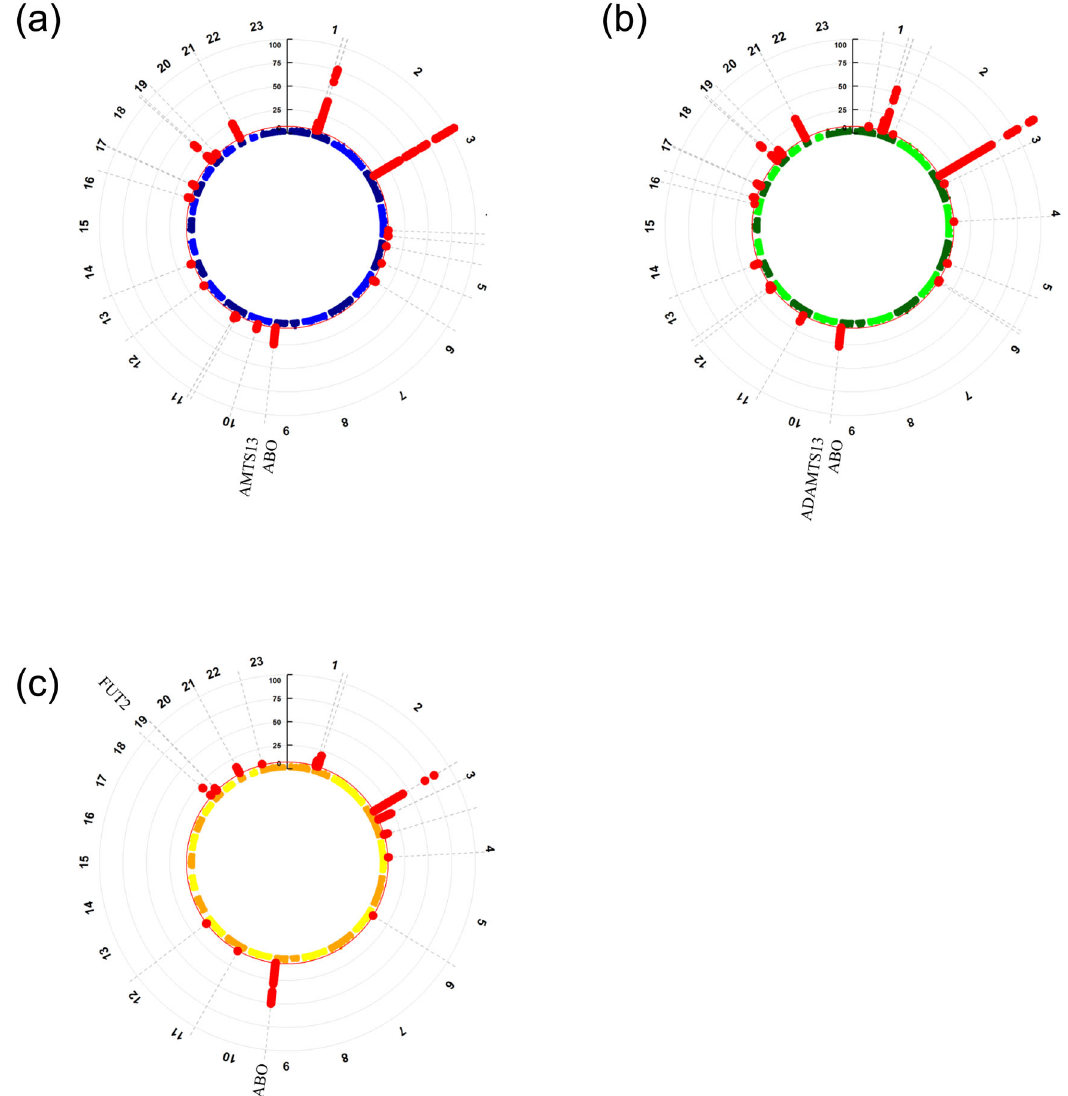
Fig. 3 Circular Manhattan plot of cross-trait analysis. a VTE and severe COVID-19; b VTE and COVID-19 hospitalization; c VTE and SARS-CoV-2 infection. Each point represents a SNP, and signi fi cant loci with meta-analysis P value <5 × 10 − 8 are colored in red. Shared loci with meta-analysis P value < 5 × 10 − 8 and single-trait P value <5 × 10 − 3 are labeled with the mapped genes. SNPs are arranged according to the chromosome position. The presented data are available in Supplementary Data 8 –